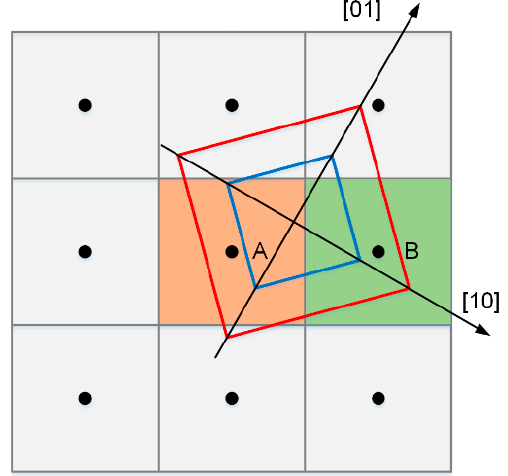
Figure 2. Schematic diagram of the capture rule in a time step calculation; cell B was captured by the envelope (the red square) of cell A at the time step.